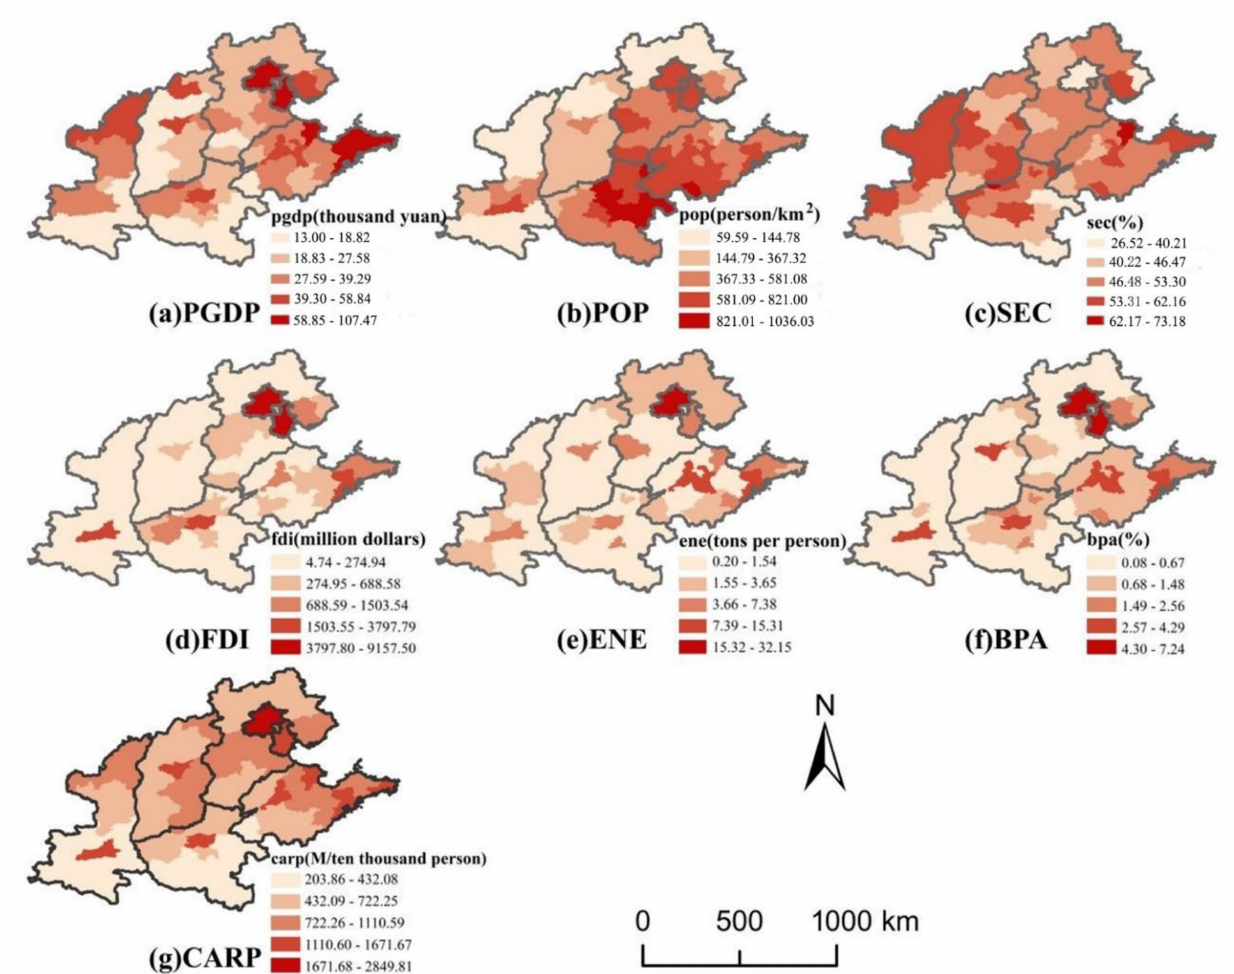
Figure 2. Spatial distribution of average values every three years of socio-economic factors from 2000 to